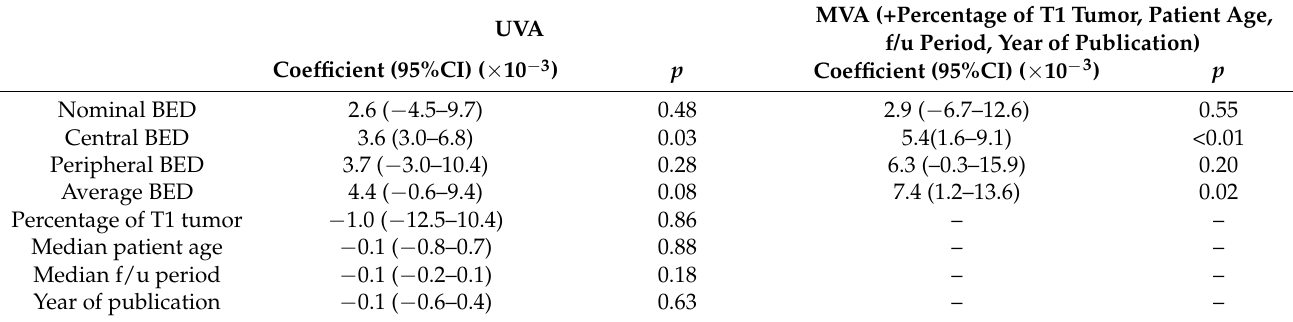
Table 2. Meta-regression analysis for 3-year local control and